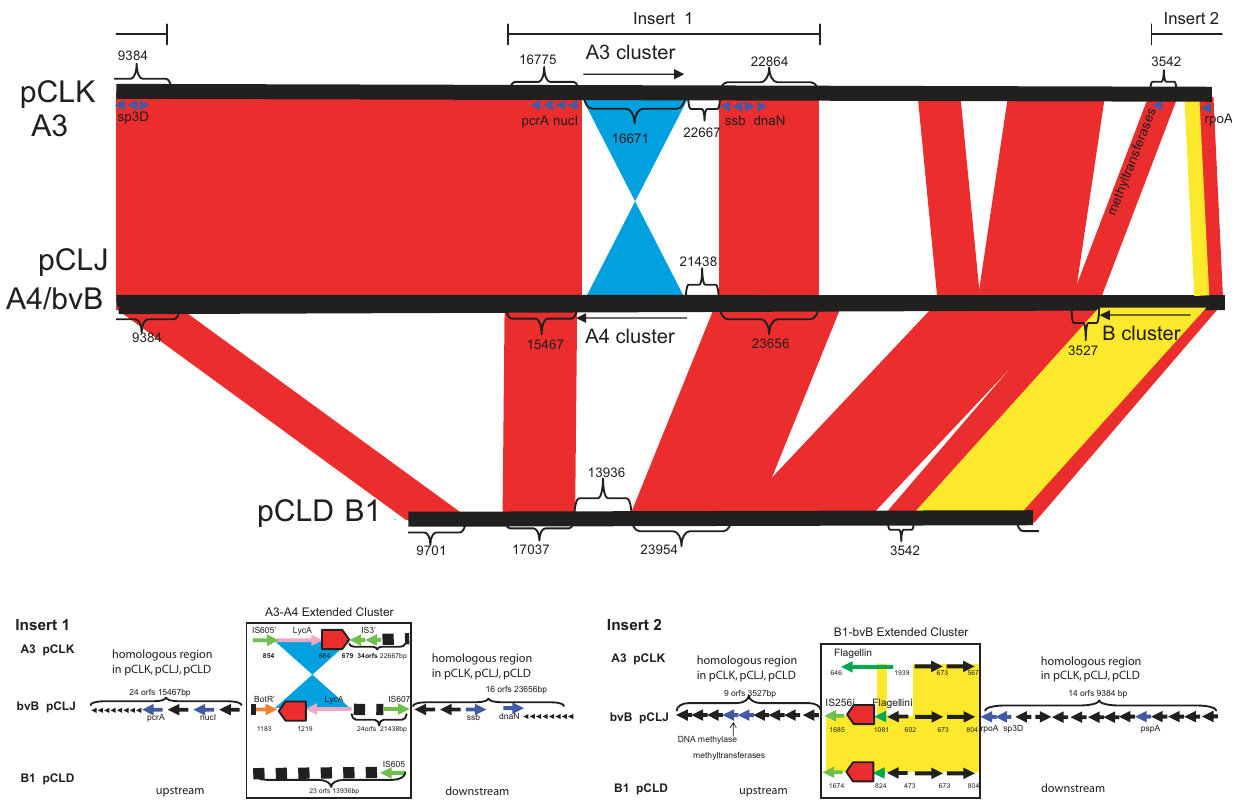
Figure 4. Plasmid synteny among pCLK (Loch Maree), pCLJ(657) and pCLD (okra). The upper panel illustrates regions of similarity (indicated in red) shared among these three plasmids. Regions that are not shared include the BoNT/B1 or BoNT/bvB gene clusters within the BoNT/A3 Loch Maree strain or the BoNT/A3 and BoNT/A4 gene clusters within the BoNT/B1 okra strain. These regions appear to have been deleted from pCLK and pCLD. Within pCLK and pCLJ an inversion, approximately 16.7 kb in size, has occurred where the toxin gene cluster for BoNT/A4 appears in the opposite direction from BoNT/A3. The lower panel expands the two regions designated as insert 1 and 2 in the upper panel. These regions detail the conserved plasmid sequences that flank the BoNT/A3 and BoNT/A4 extended cluster (15.4 kb upstream to 23.6 kb downstream) and the BoNT/B1 and BoNT/bvB extended cluster (3.5 kb upstream to 9.3 kb downstream).